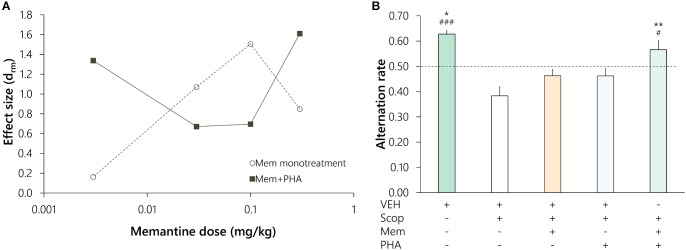
Comparison of effect sizes of memantine (Mem) monotreatments and its combinations with PHA-543613 (PHA) against scopolamine-induced amnesia (A), and pooled analysis of cases (n = 26) with non-effective memantine monotreatments (B). On part (B), significance level of post hoc comparisons between a given treatment and scopolamine alone treatment were marked with asterisks above the bars: ∗p < 0.05, ∗∗p < 0.01. Hash symbols mark that the alternation performance after a given treatment was significantly higher than the chance level (0.5, dashed line): #p < 0.05, ###p < 0.001.